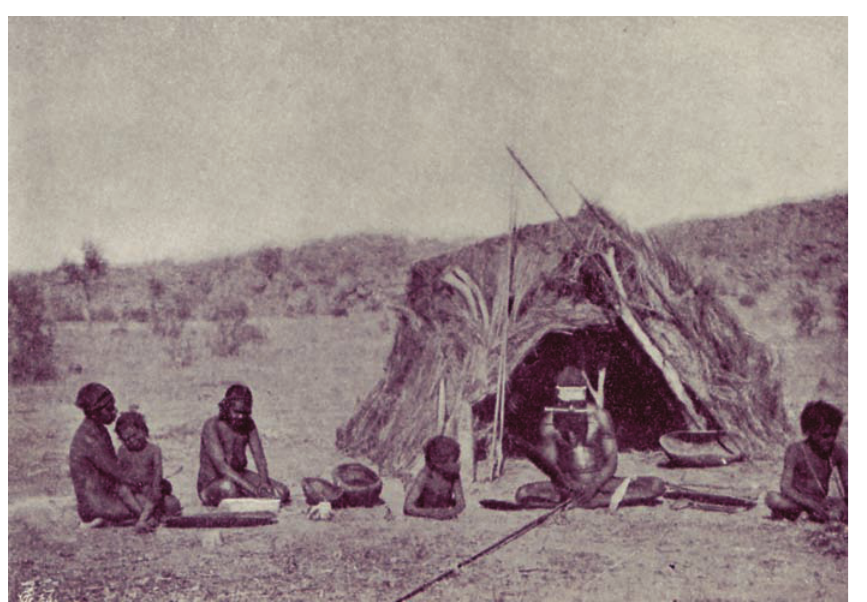
Figure 2 A family group of Australian Aborigines from the Arunta tribe